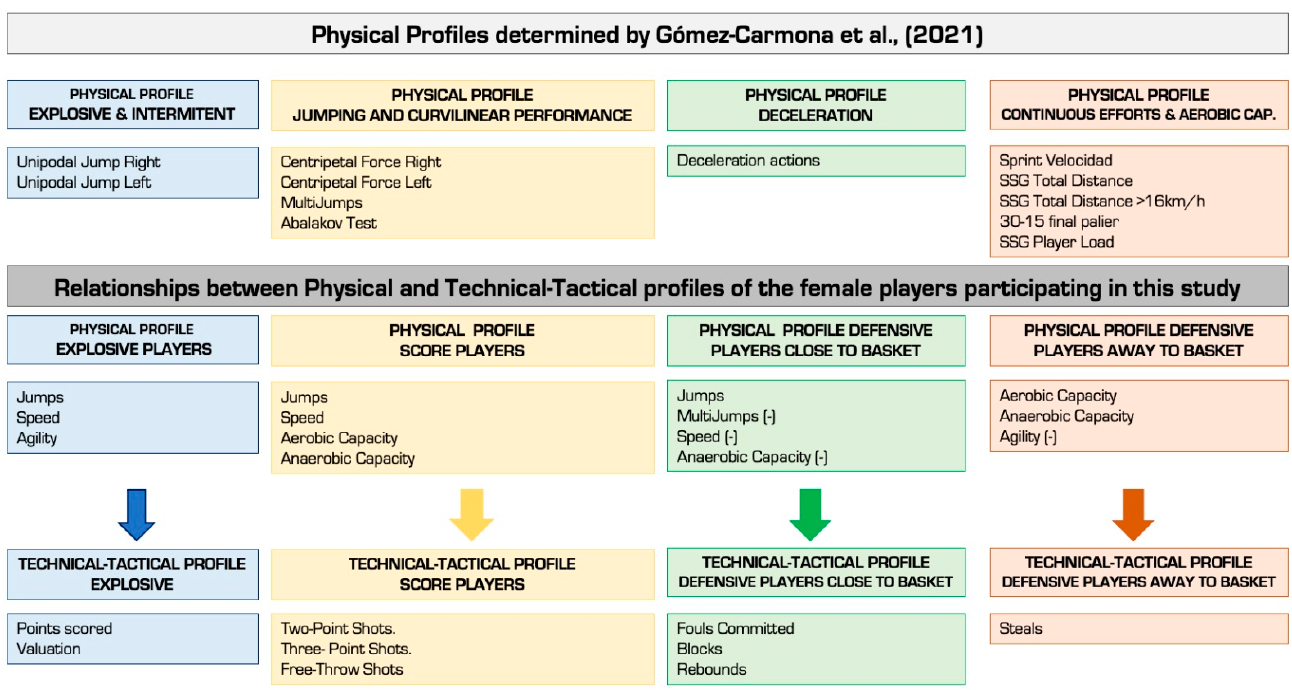
Figure 3. Representation of the relationships between physical and technical–tactical profiles [32].